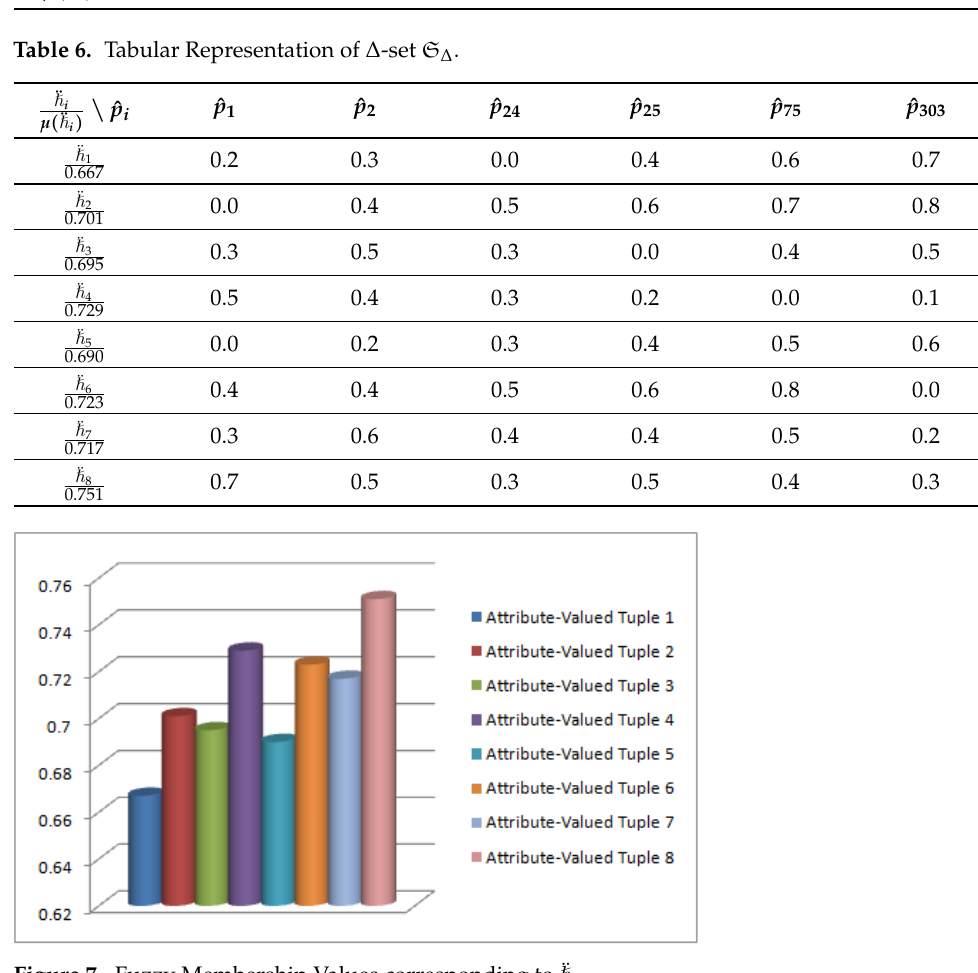
Figure 7. Fuzzy Membership Values corresponding to ¨ (cid:125) i